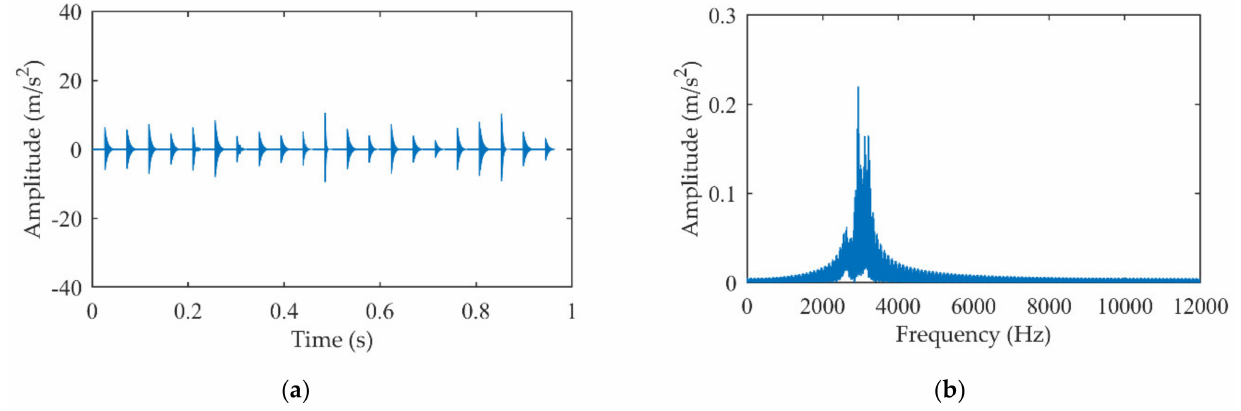
Figure 18. The extracted impact signal by EMD + MP: ( a ) Time domain signal; ( b ) Ampli- tude